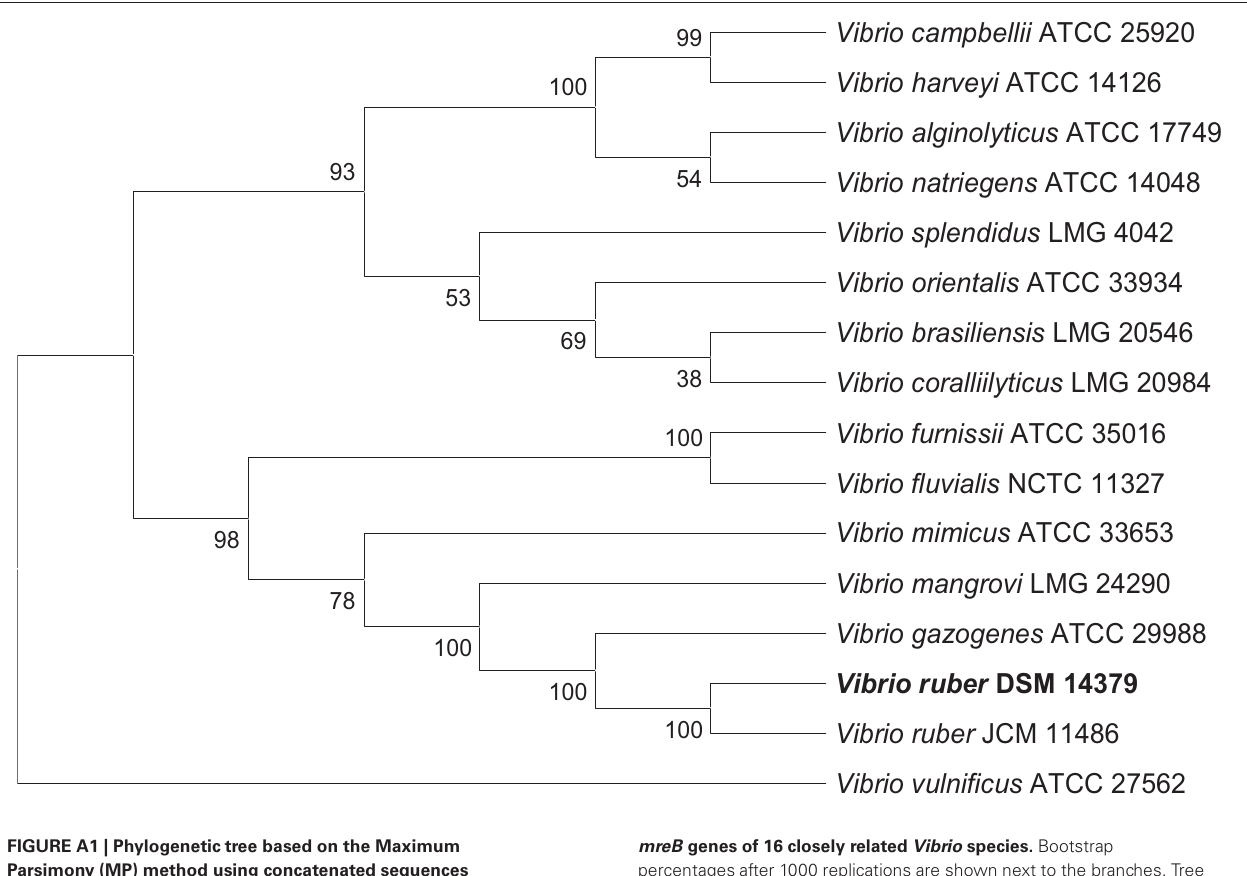
mreB genes of 16 closely related Vibrio species. Bootstrap percentages after 1000 replications are shown next to the branches. Tree length is